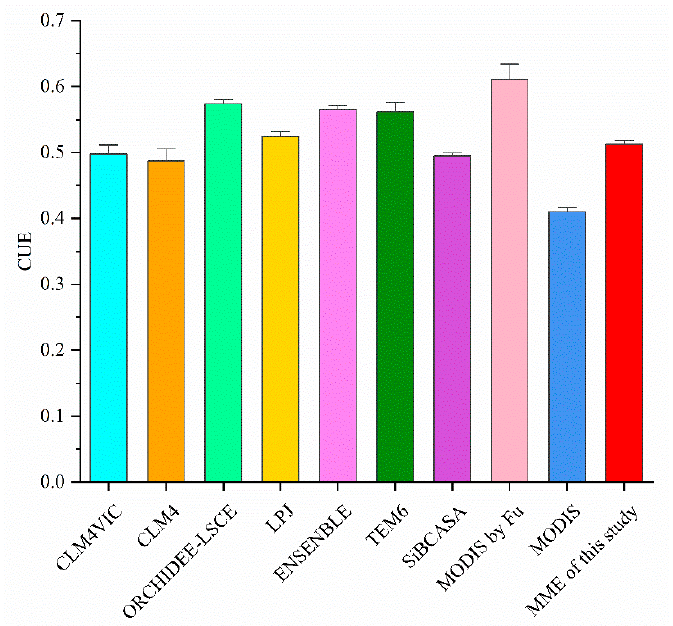
Figure A5. The mean annual value and standard error of CUE of different research results among models and MODIS over the Qinghai-Tibet Plateau during 2000–2010.